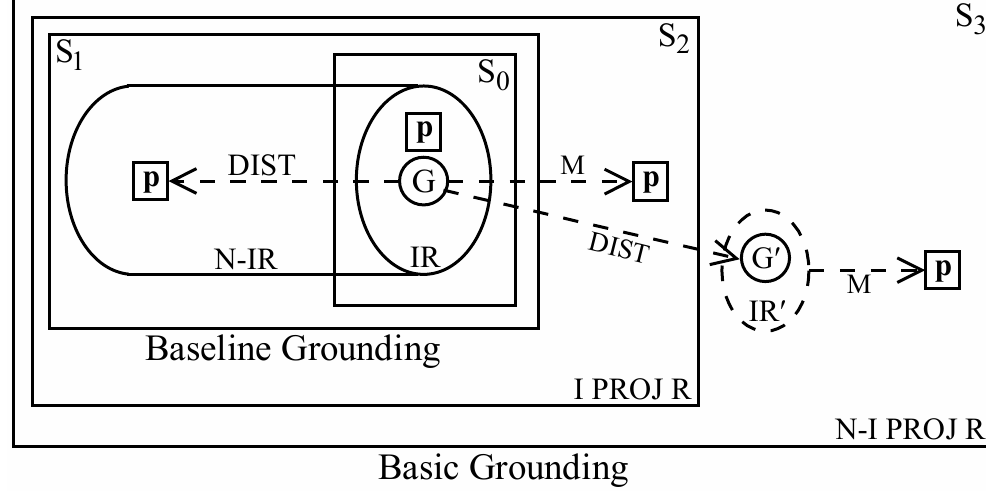
Figure 3. Summary of the basic grounding system.